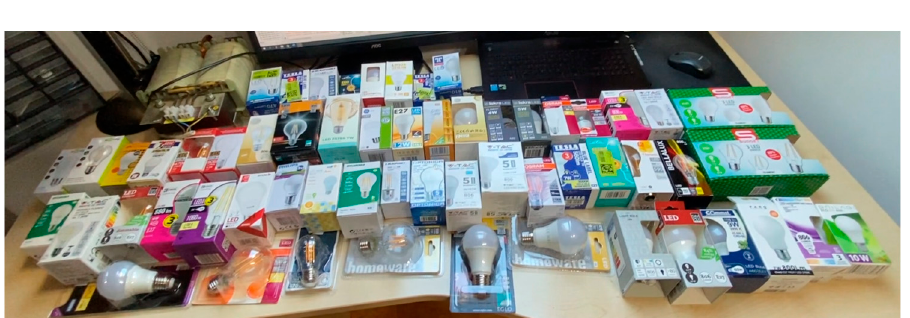
Figure 20. 59 measured LED light bulbs.